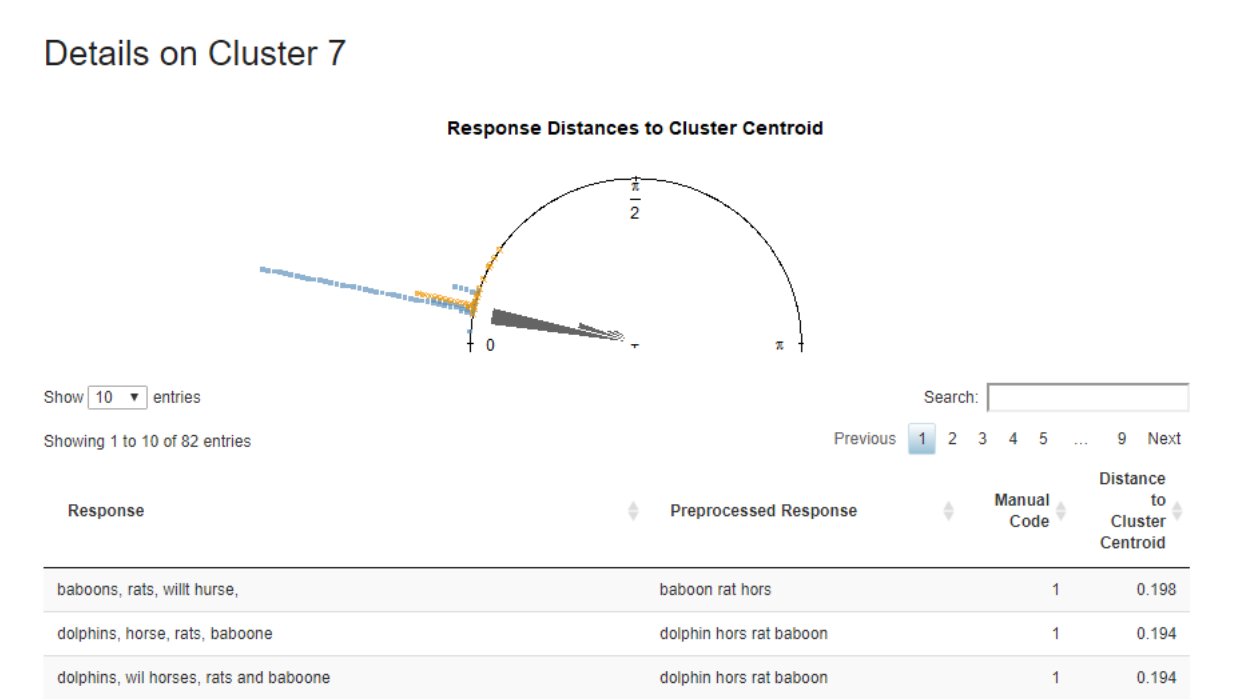
Figure 9. Detail view with response-specific distance information. The distance of the response vector to the respective cluster centroid is displayed in a rose plot.